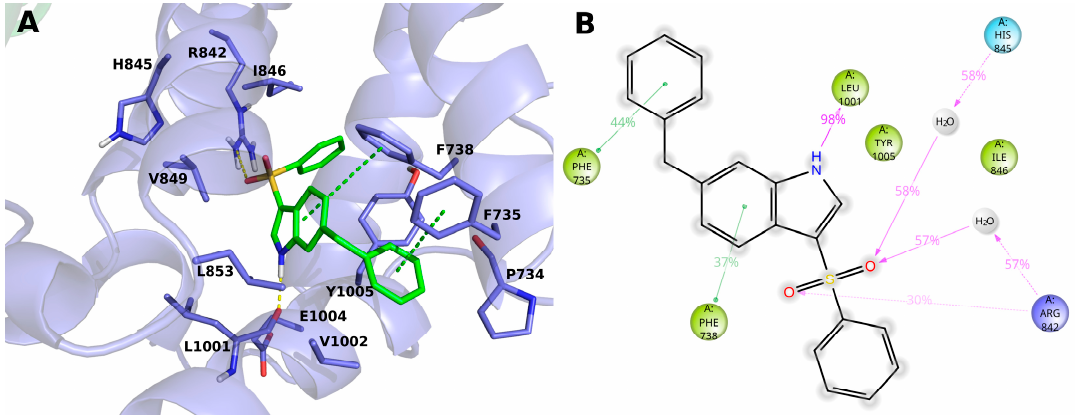
Figure 4. ( A ) Docking-predicted pose of 15 ( BB 0322720 ) into hTRPM8 723–1013 . hTRPM8 is represented in cartoons, and its residues interacting with the ligand are represented in sticks. 15 ( BB 0322720 ) in its hTRPM8-bound conformation is represented in solid green sticks. H-bonds are highlighted by yellow dashed lines, π – π interaction by green dashed lines. ( B ) Ligand interaction diagram of 15 ( BB 0322720 ) in complex with hTRPM8. Only residues interacting with the ligand for at least 40ns out 120ns of MD simulation are shown. Residues are coloured according to the following scheme: cyan—polar; blue—charged (positive); green—hydrophobic; gray—water molecule. Grey halos highlight solvent exposure. H-bonds are represented by magenta arrows (dashed when side-chain atoms are involved); green solid lines represent π – π interactions.